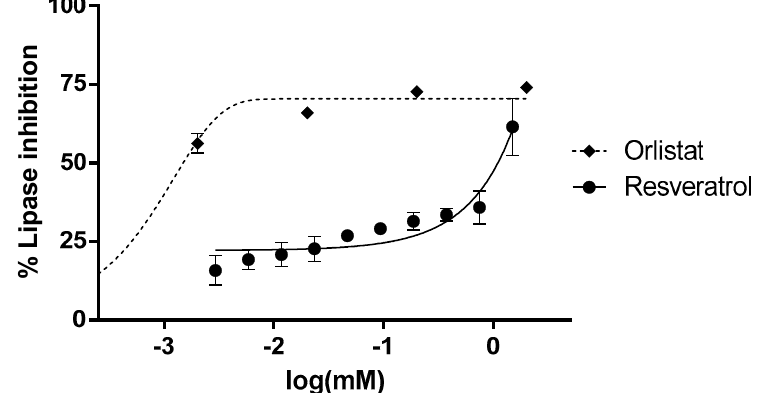
Figure 2. Lipase activity is dose-dependently inhibited by resveratrol. The x axis represents the logarithm of the concentration in mM. Tested concentrations of resveratrol were in the range of 0.003–1.5 mM. Orlistat was tested as a positive control drug in the range of 0.002–2 mM. IC 50 were calculated by non-lineal regression, using GraphPad Prism 6. All concentrations were tested at least in triplicate, each point representing mean ± SEM.